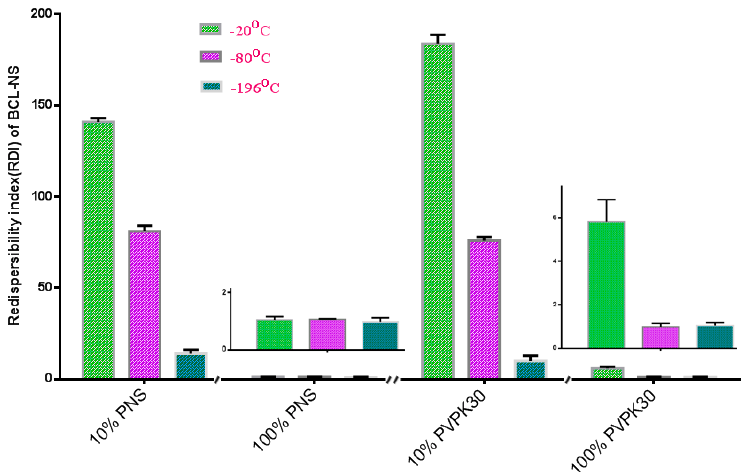
Figure 3. Redispersibility of the frozen BCL-NS/PNS and BCL-NS/PVPK30 at − 20 °C, − 80 °C and − 196 °C (mean ± S.D., n = 3). − 196 ◦ C (mean ± S.D., n =